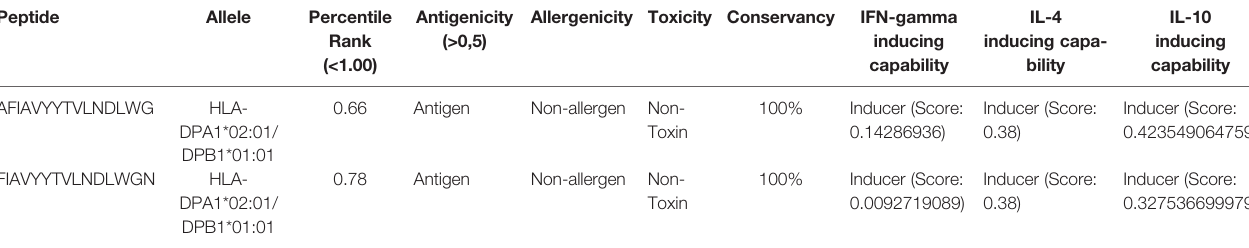
TABLE 3 | Promising HTL epitopes with their percentile rank, antigenicity, allergenicity, toxicity, conservancy, and cytokine inducing ability (IFN-gamma, IL-4, and IL-10).